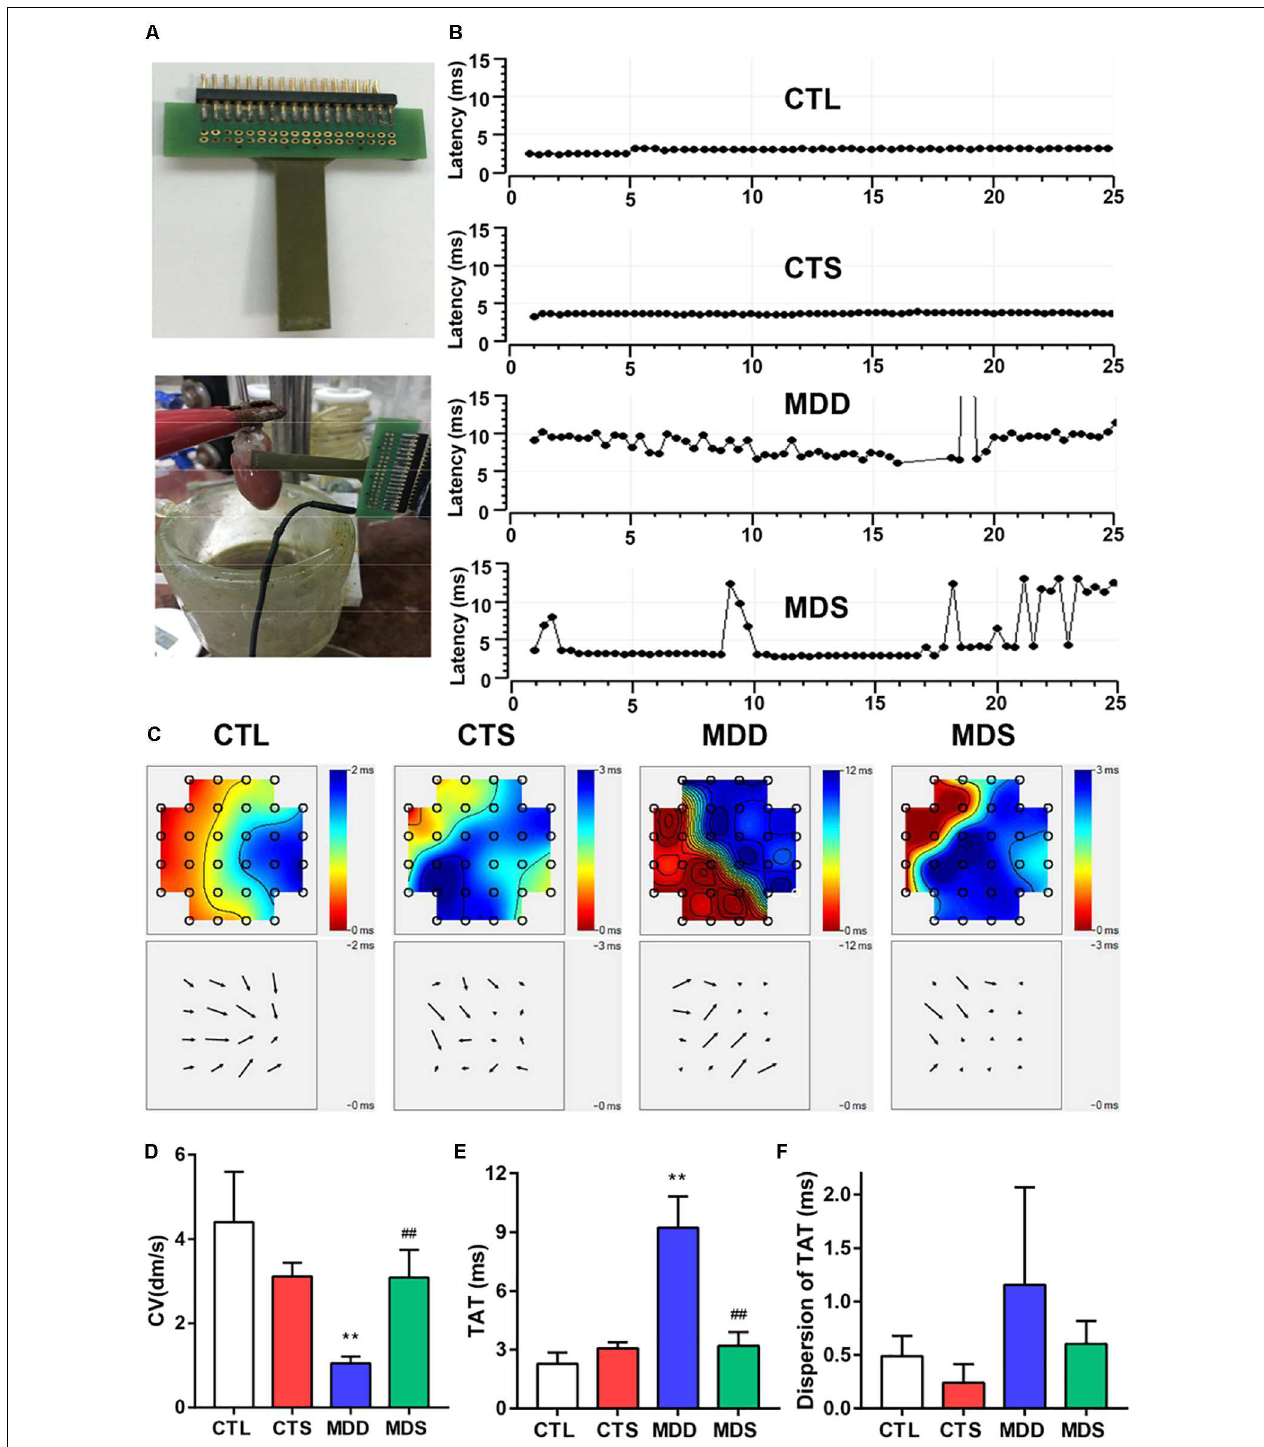
FIGURE 3 | SA4503 improved the left atrial conduction function after CUMS. (A) Representation of an MEA electrode. (B) Representative examples of conduction heterogeneity map in the left atrium. Conduction was more heterogeneous in rats with MDD compared to the MDS rats. (C) Representative examples of the isochronous map in the left atrium by MEA recordings. Areas of isochronal crowding were found in rats with MDD. The degree of crowding decreased in the MDS rats ( n = 6). (D) Changes in CV in each group. (E) Long-term trace of instantaneous beating TAT. (F) The dispersion of the dots represents the dispersion of TAT. CUMS, chronic unpredictable mild stress; MEA, multielectrode array; TAT, total activation time; CV, conduction velocity. ∗∗ P < 0.01 vs. CTL group; ## P < 0.01 vs. MDD group.